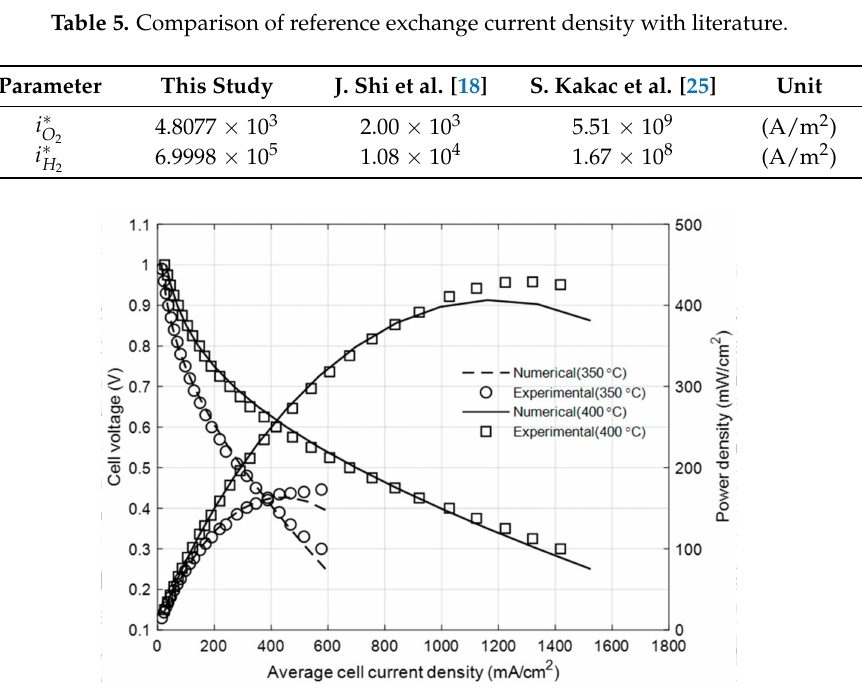
Figure 2. Comparison between numerical prediction and experimental data from Ref.